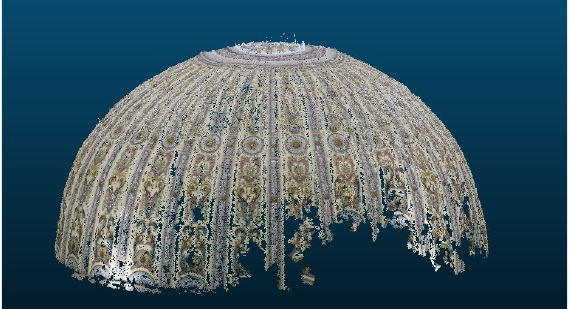
Figure 7: VisualSFM dense point cloud.